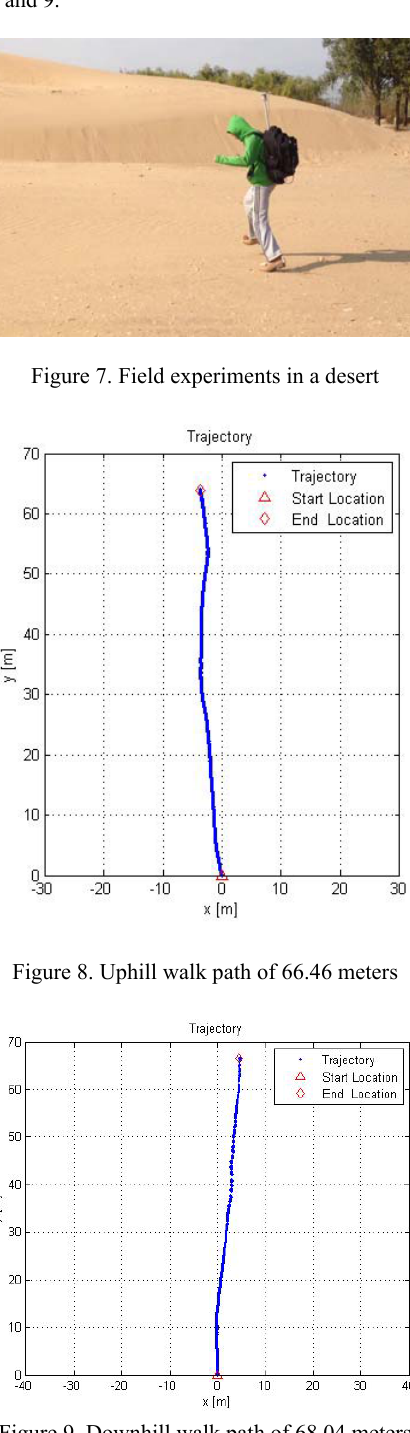
Figure 9. Downhill walk path of 68.04